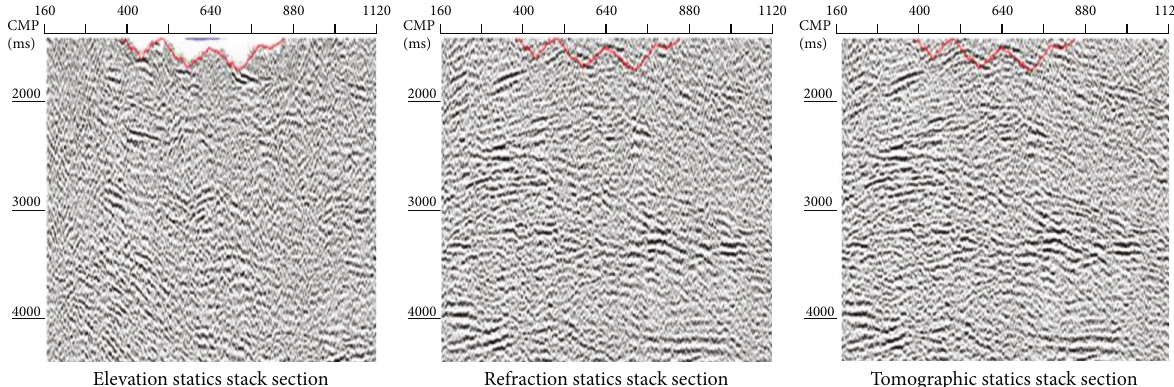
Figure 14: The sections processed by elevation correction, refraction correction, and tomography correction.